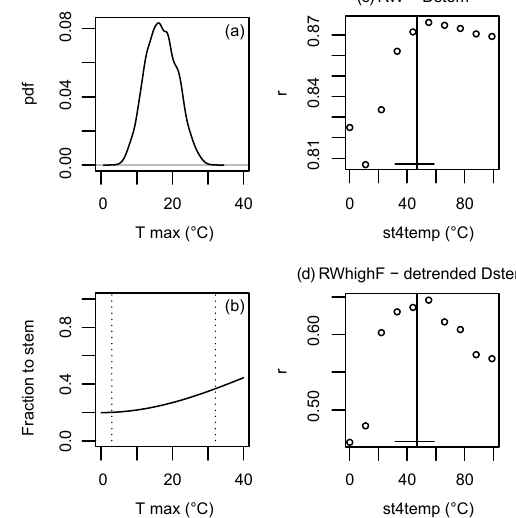
Figure 8. Temperature dependence of the daily partition of car- bon in phase 4 (growth and accumulation phase in summer) when MAIDEN is run with the parameters of plausible block stem at the center of the region with ring width data in the northern Quebec taiga. (a) Probability density of daily maximum temperature values in summer. (b) Relationship between maximum temperature values and portion of carbon allocated to the stem (Eq. 6). The vertical dashed lines show the range of maximum temperature values. Pan- els (c–d) show how the parameter st4temp influencing this process impacts the correlations between simulated Dstem and observed ring width data (RW or RWhighF) when all other parameters are fixed to the values of plausible block stem and st4temp varies over its prior acceptable range. The vertical line is the selected value for plausible block stem, and the horizontal line is the 90% confidence interval based on the parameter’s posterior density (Fig.